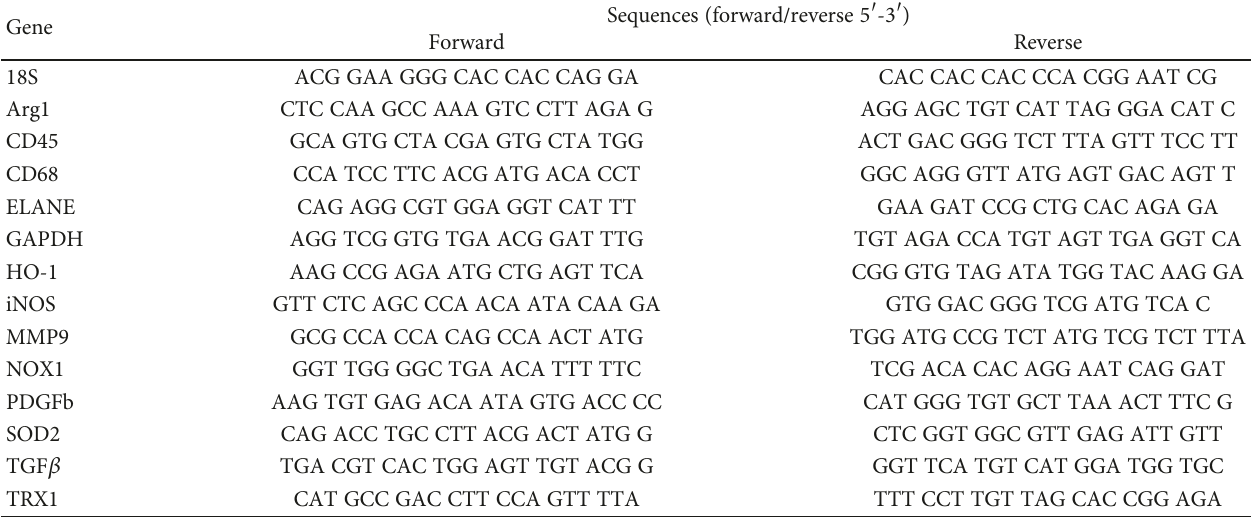
Table 1: Primer sequences for real-time reverse transcription polymerase chain